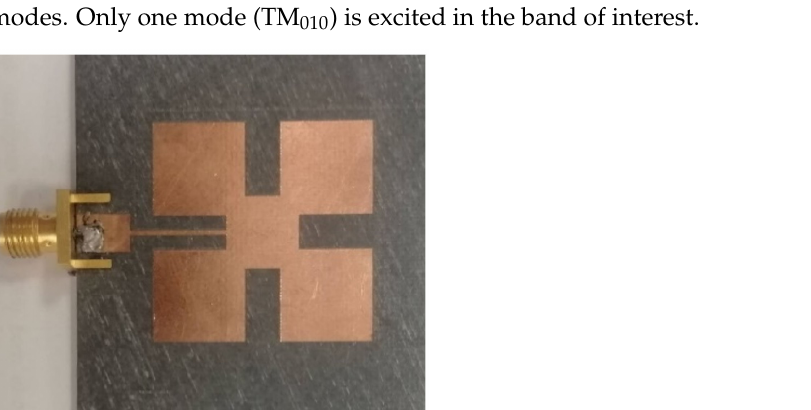
Figure 1. Single antenna element (Ant 1). The patch dimensions are optimized to operate at the 2.45 GHz frequency as: patch length and width = 28 mm, slot length = 9.3 mm, and slot width = 4.5 mm.